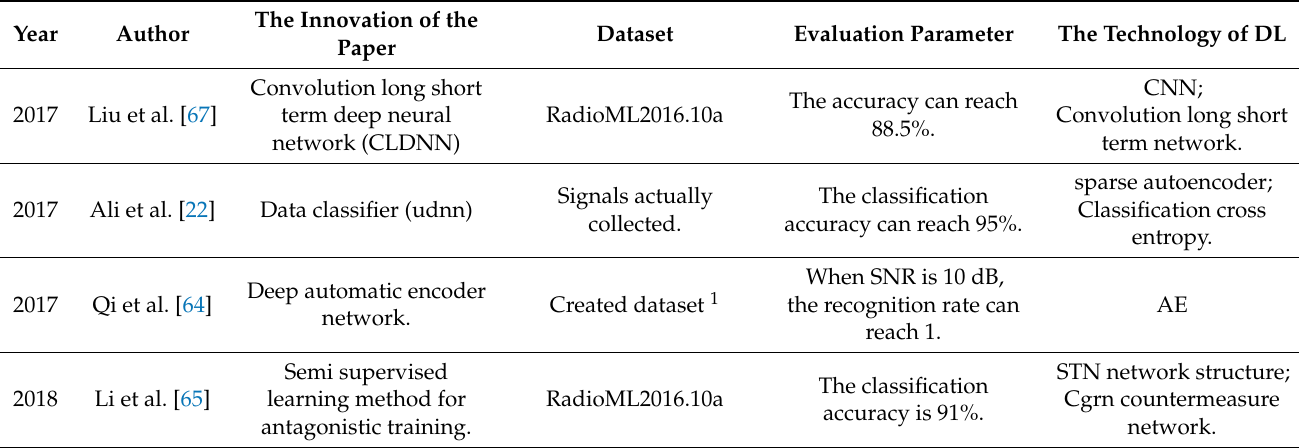
Table 5. Other radio modulation recognition